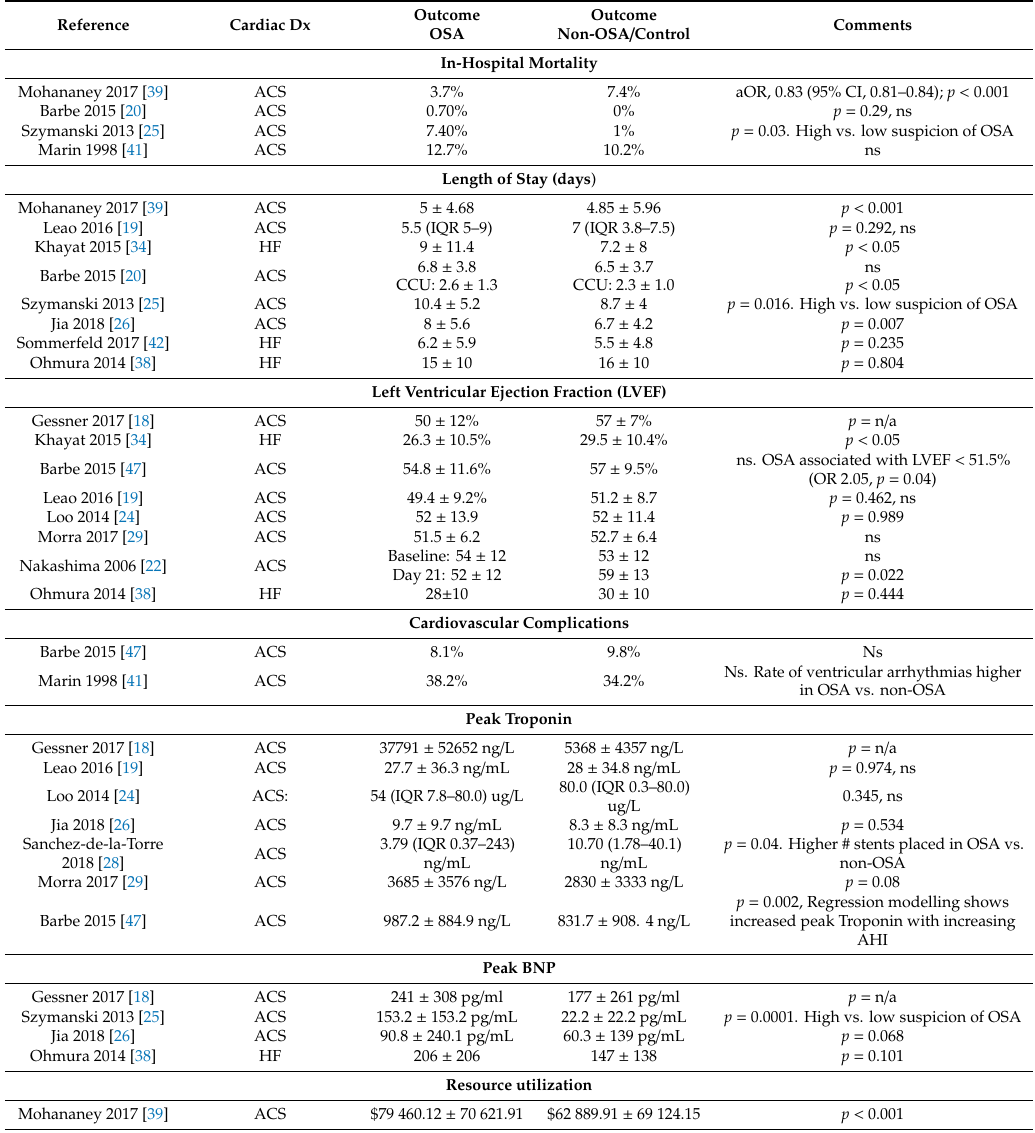
Table 2. In-hospital outcomes of patients with OSA hospitalized for